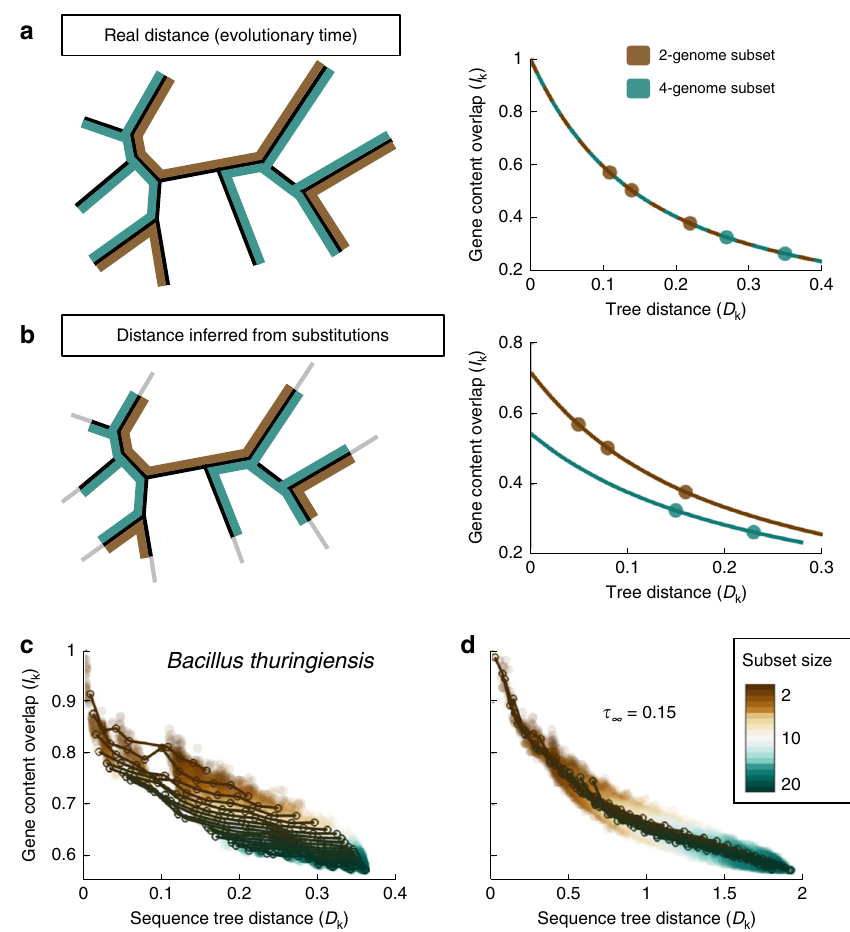
Fig. 1 Compression of terminal branches of sequence-based phylogenetic trees detected through analysis of gene content decay curves. a If tree distances are proportional to the true evolutionary time, the fraction of genes shared by a subset of genomes will decay with the total length of the subtree, and the decay curves will be the same regardless of the number of genomes in the subset. For illustration purposes, three subsets of 2 genomes are highlighted in brown, and two subsets of 4 genomes are highlighted in green. b Homologous recombination between pairs of closely related genomes erases recent sequence divergence which results in an underestimation of the evolutionary times associated with terminal tree branches. Such underestimation leads to gene content decay curves that depend on the number of genomes included in the subset. Accordingly, the decay curve of subsets of 4 genomes is different from the decay curve of subsets of 2 genomes. c The gene content decay curves of the Bacillus thuringiensis / cereus / anthracis group are compatible with a scenario of recombination-driven shortening of the terminal branches of the phylogenetic (substitution-based) tree. Based on the tree from Fig. 2a. d If the recombination model is used to correct for unobserved variation ( fi t in Fig. 2c, left panel), overlapping decay curves are obtained. Source data